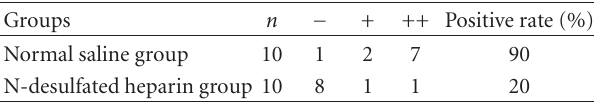
Table 1: E ff ect of N-desulfated heparin on bFGF expression in gastric cancer in vivo (mean ± SD).